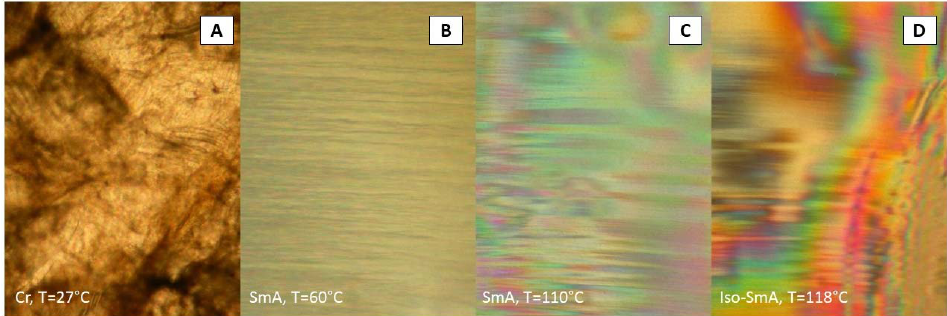
Figure 4. Microphotographs of the textures for SC-LCE 2 elastomer: ( A ) texture at room temperature (27 °C); ( B ) texture of the SmA phase (60 °C); ( C ) texture of the SmA phase (110 °C); ( D ) texture of the Iso-SmA phase transition (118 °C). The width of the pictures is about 200 μ m.